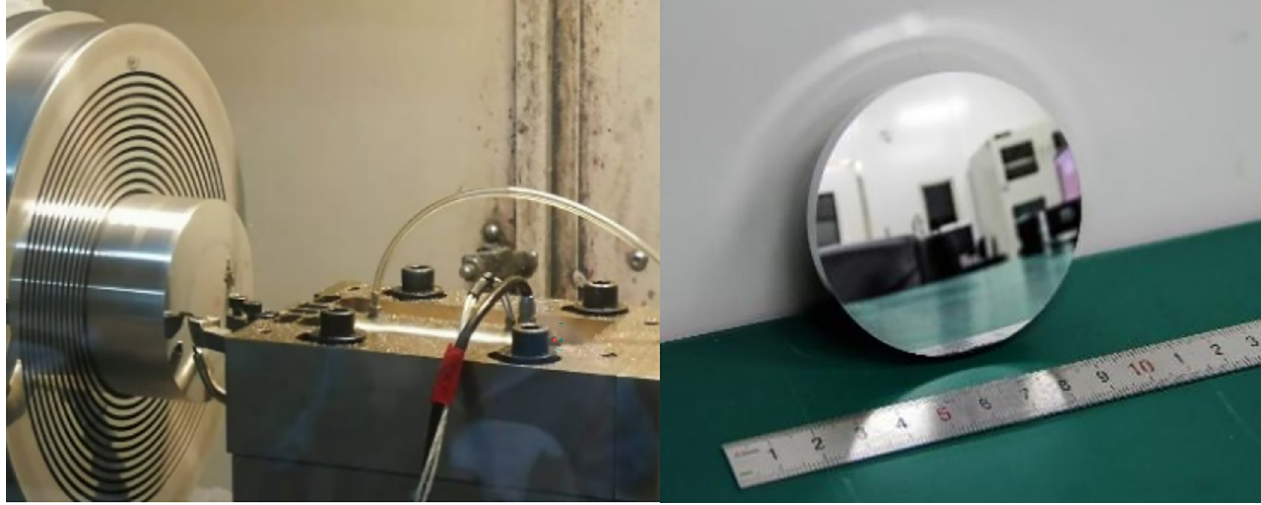
Fig 15. The processing site and test